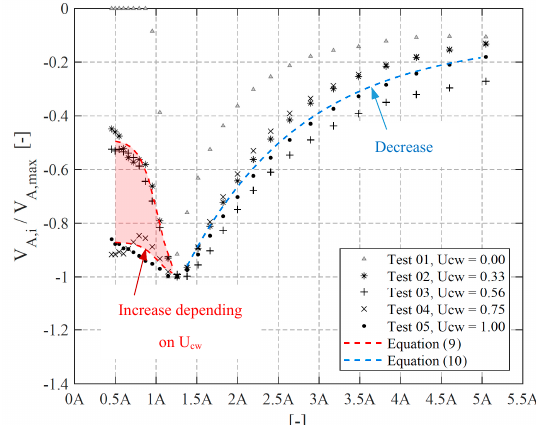
Figure 8. Cumulative erosion volume V A , i (see Equation (4)), normalized with the maximum value V A , max as a function of the distance A to the center of the structure, compared with predicted erosion volumes relating to Equation (9), A < 1.25 A and Equation (10) for A > 1.25 A, R 2 = 0.87 for Equation (8) including Equations (9) and (10).